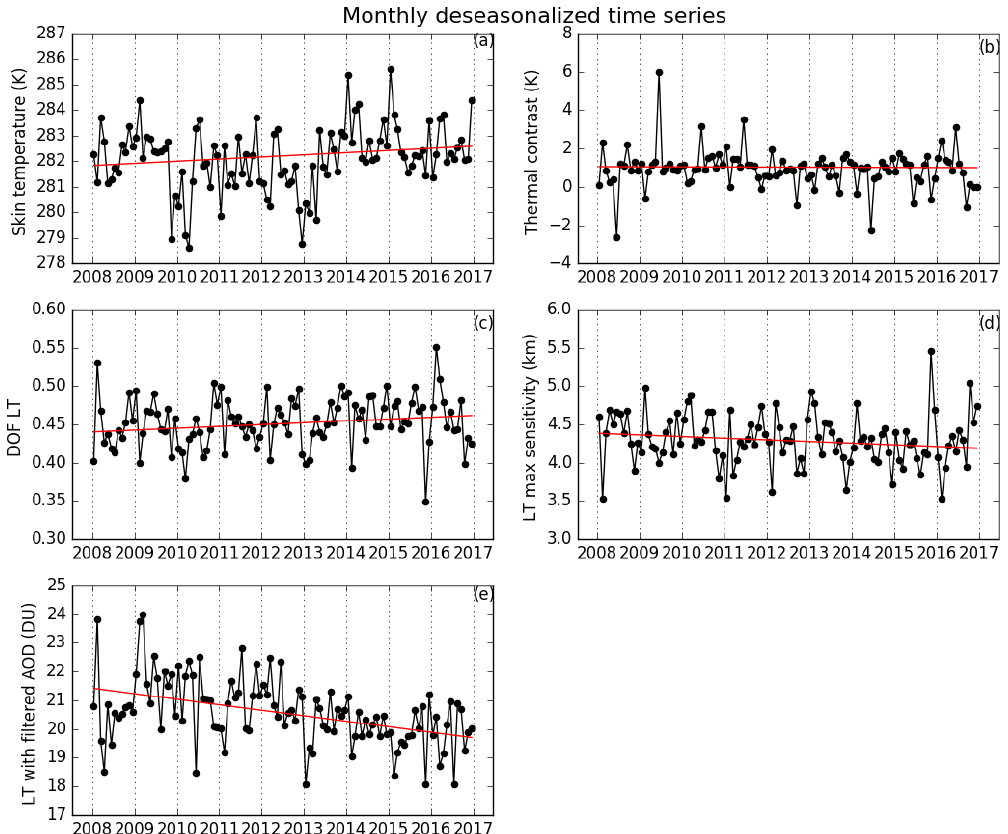
Figure 2. Monthly deseasonalized time series and their associated linear trends of internal and external parameters used to test the retrieval stability: (a) skin temperature, (b) thermal contrast, (c) DOF, (d) , altitude of maximum sensitivity, and (e) LT ozone filtered from large aerosol